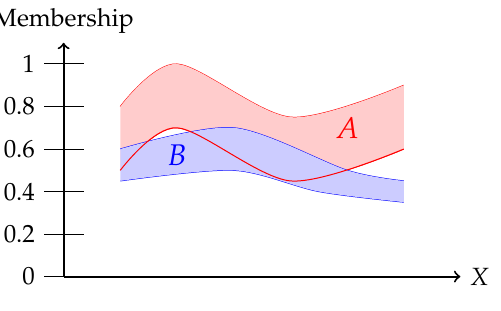
Figure 5. Not embedded